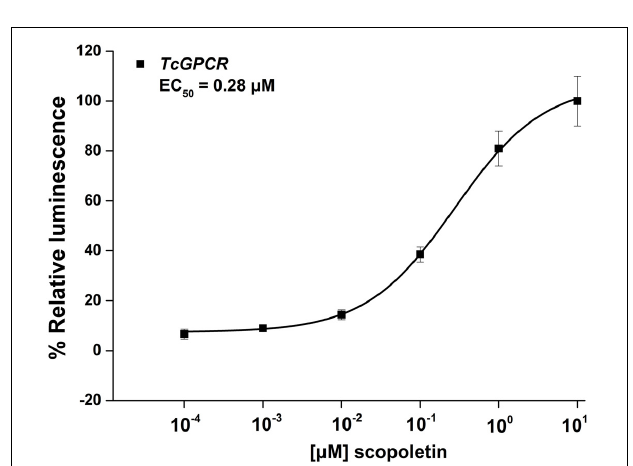
FIGURE 12 | Relative activity of Chinese hamster ovary cells transfected with T. cinnabarinus G-protein-coupled neuropeptide receptor (GPCR) and activated with scopoletin. Concentration-response curves for luminescence induced by scopoletin. Results are means ± SD ( n =